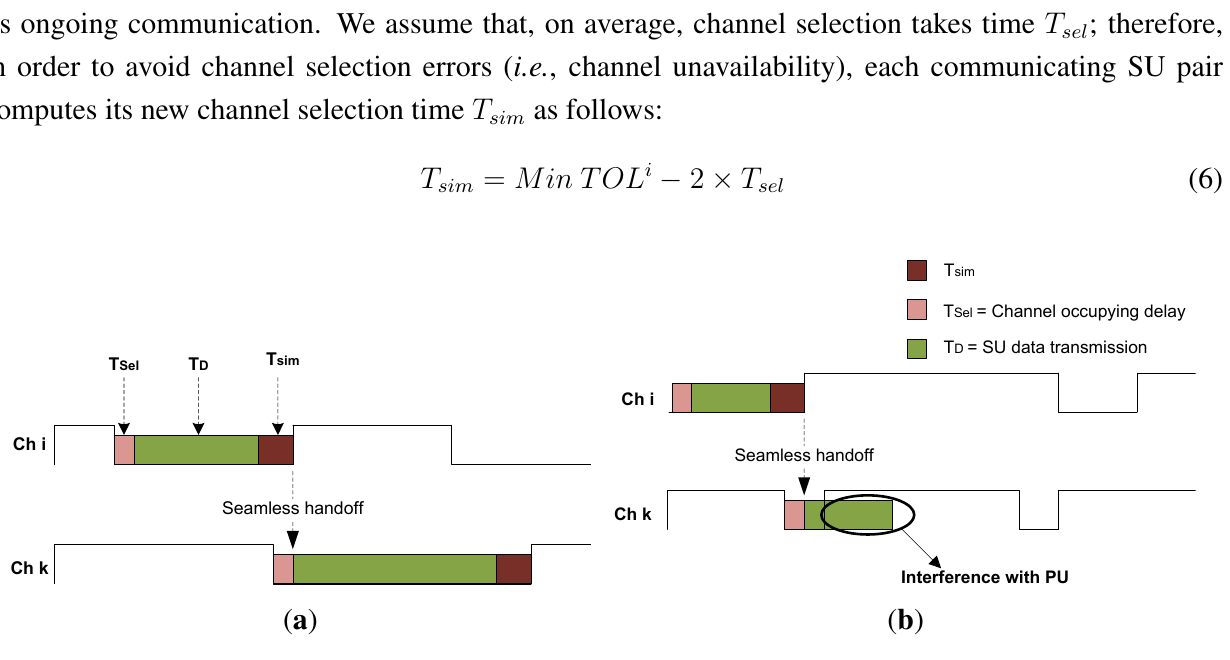
Figure 6. Predictive and fast channel switching scheme. ( a ) Predictive channel switching; ( b ) Predictive channel switching with